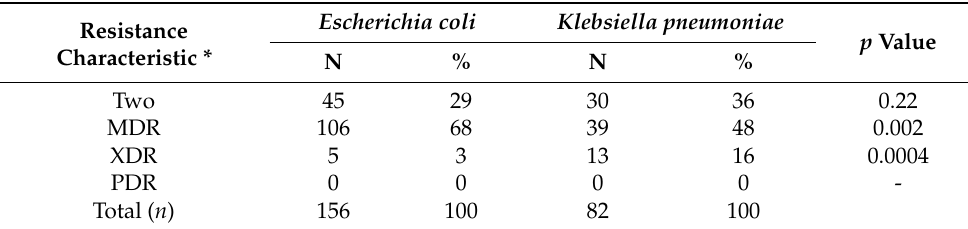
Table 3. Classification of uropathogens in multidrug-resistant (MDR) and extensively drug-resistant (XDR) bacteria. Escherichia coli Resistance Characteristic *